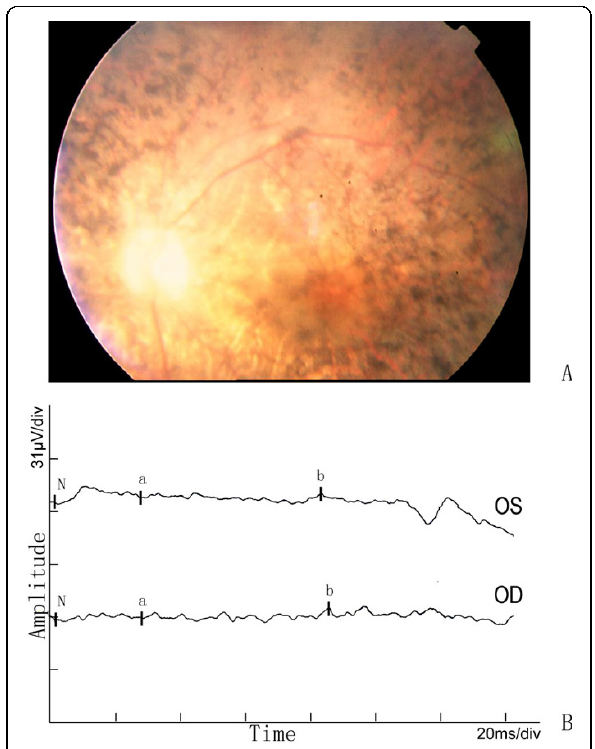
Figure 2 Fundus photographs and ERG of the proband in the Chinese arRP family . The features of waxy-pale disc, arteriolar attenuation, and bone-spicule pigment deposit in the mid- peripheral retina are shown in A. The full-field ERG in the proband in B, either a-wave or b-wave has obvious reduced amplitude and prolonged response time in both